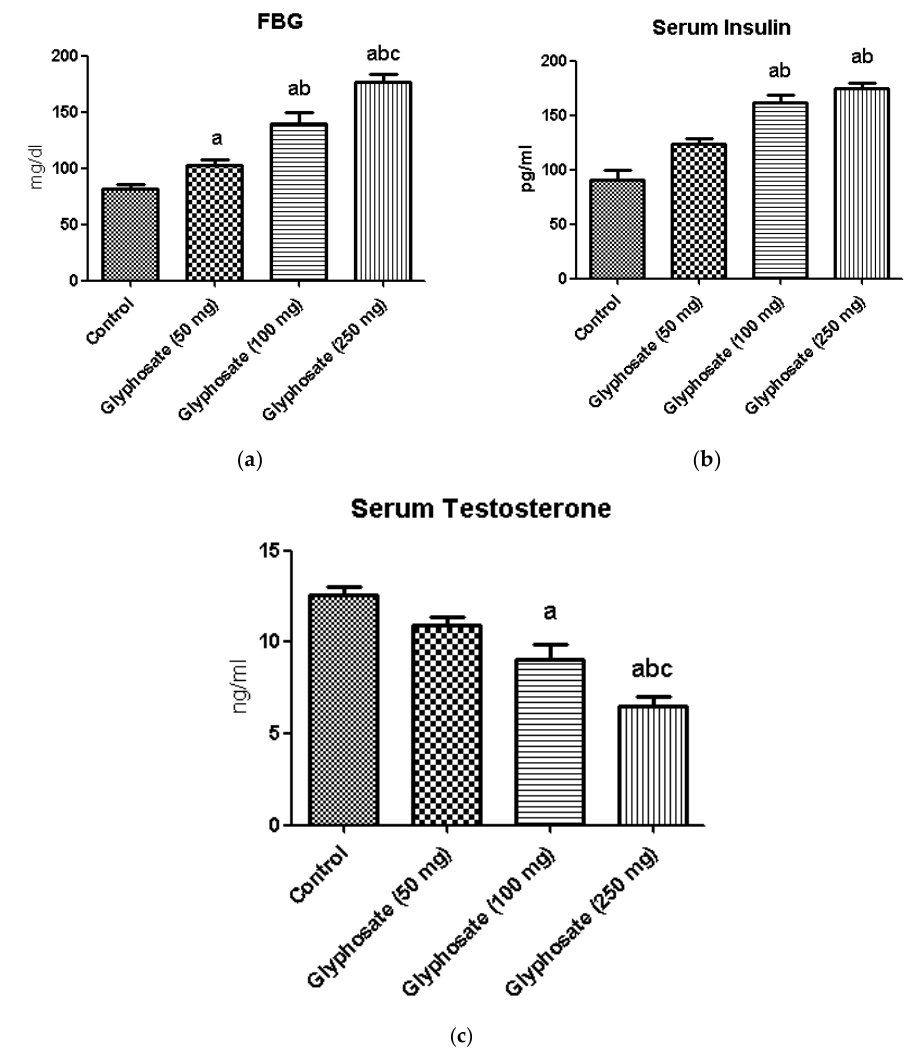
Figure 1. ( a – c ): The effect of glyphosate on FBG ( a ), serum insulin ( b ) and the serum testosterone ( c ) in control and glyphosate treated rats. Data were expressed as mean ± SEM where n = 6 rats for each group. Values significant at p < 0.05 were analyzed with a — control, b — glyphosate (50 mg/kg b.wt.), and c — glyphosate (100 mg/kg b.wt.).